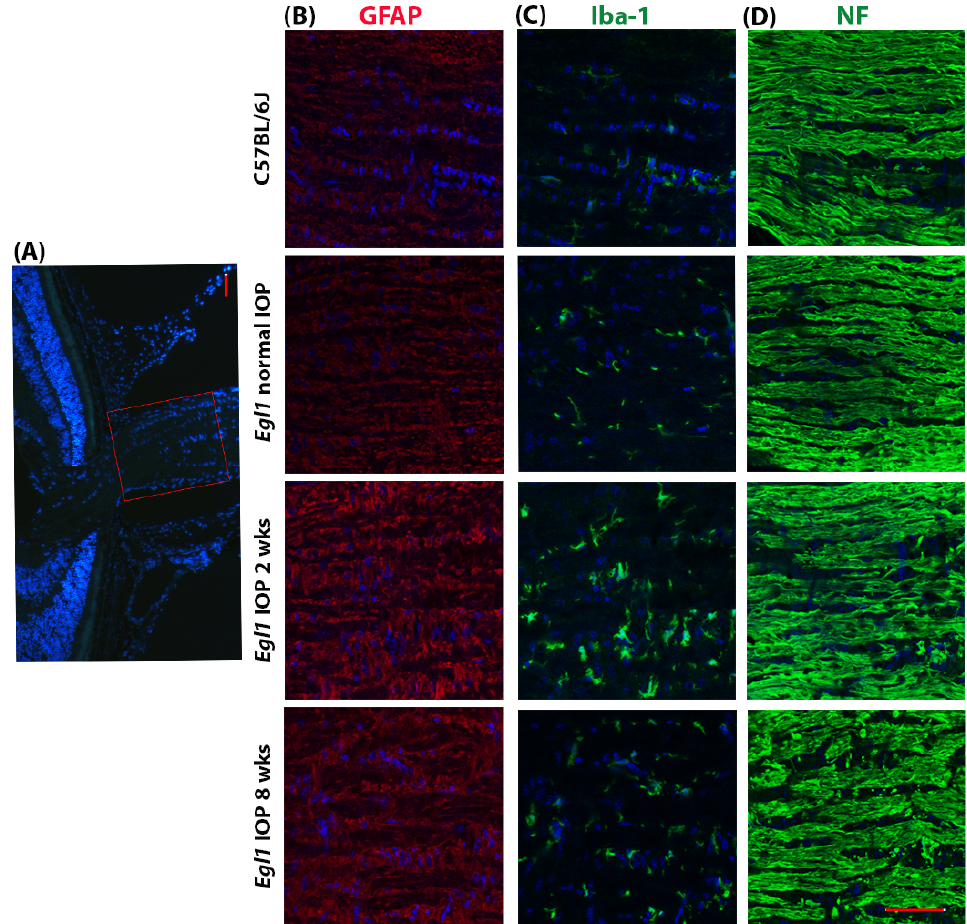
Figure 6. Glaucomatous ONH changes in egl1 mice. Representative immunofluorescence staining images show increased expression of GFAP and Iba-1 and disorganized NF in the egl1 mice. Images were taken in the rectangular boxed area in ( A ). ( B – D ) Columns show GFAP (red), Iba-1 (green), and NF (green) staining in C57BL/6J wildtype and egl1 mice with various IOP levels. Nuclei were labeled with DAPI (blue). Scale bars = 50 µm.